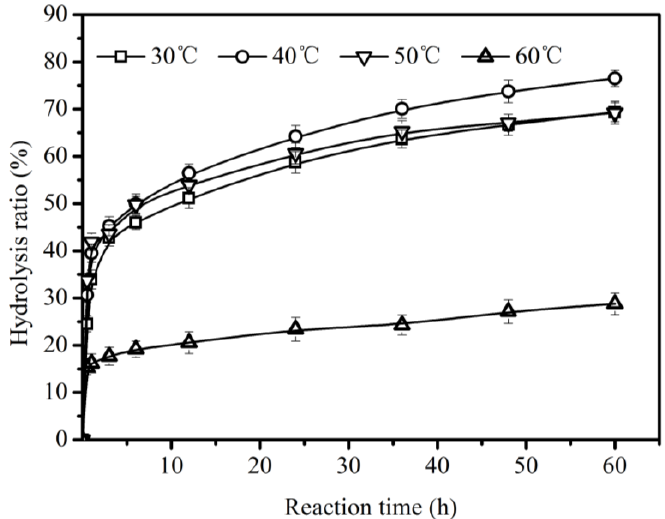
Figure 3. Effect of reaction temperature on the hydrolysis of CO using Lipozyme TLIM. Reaction conditions: 1.78 g Lipozyme TLIM and 0.031 mol CO in the presence of 5.51 mL water at 200 rpm.